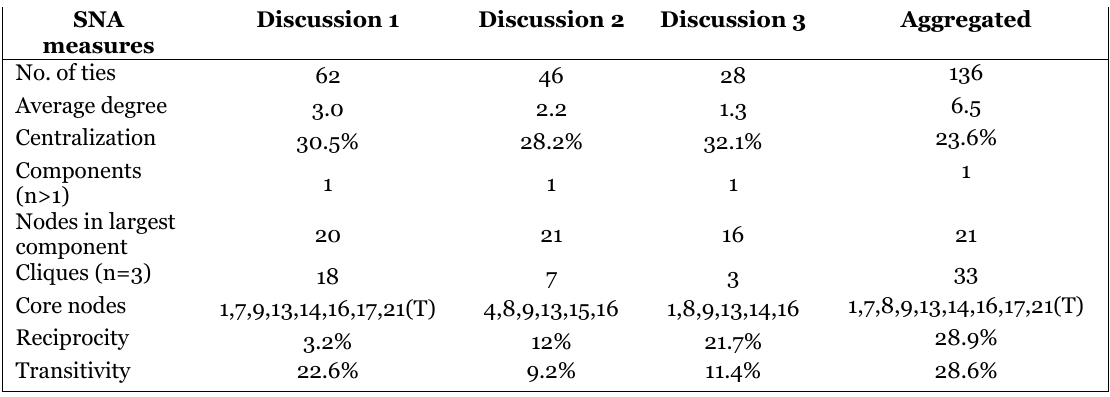
Whole-Network SNA Measures for Successive and Aggregated Discussion